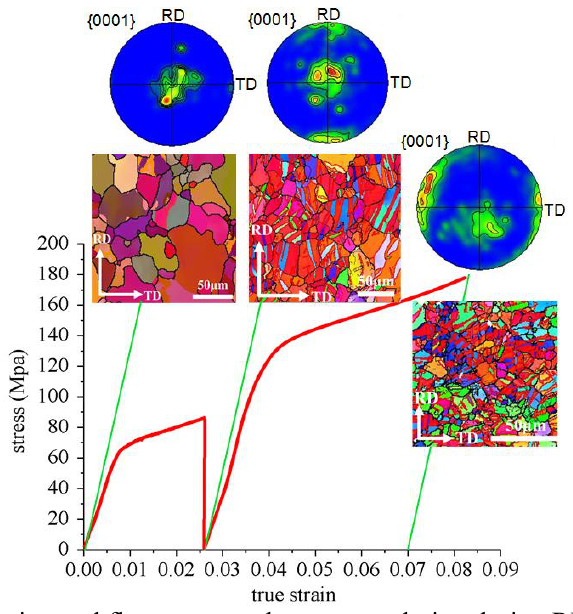
Fig. 3. Experimental flow stress and texture evolution during